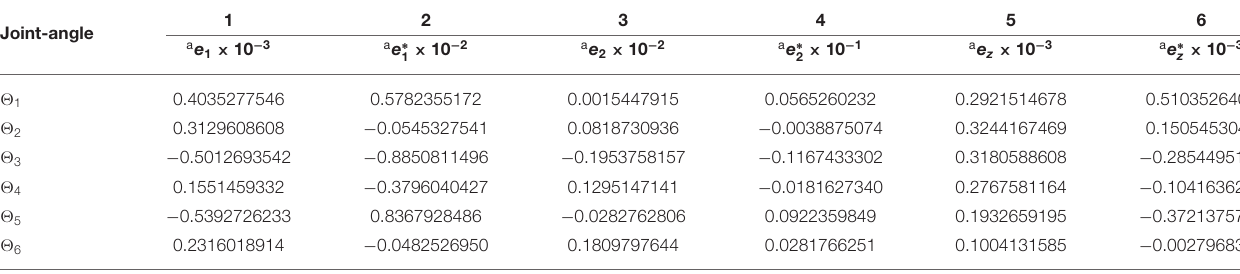
TABLE 1 | Values of e synthesized by SMCS-1, SMCS-2, and SMCSvZ in case A and case B with e = 2 ( t f ) − 2 g . Joint-angle